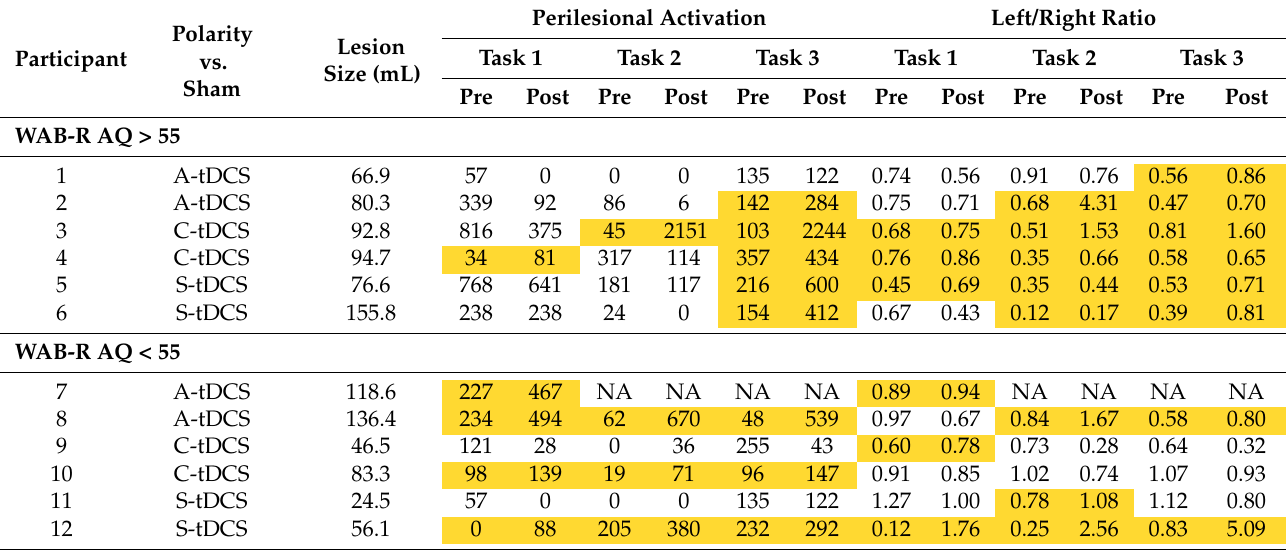
Table 7. Number of activated voxels within a 5 mm area around the lesion (perilesional) and the ratio of activated voxels between the left vs. right hemisphere (left/right ratio) at pre- and post-treatment.